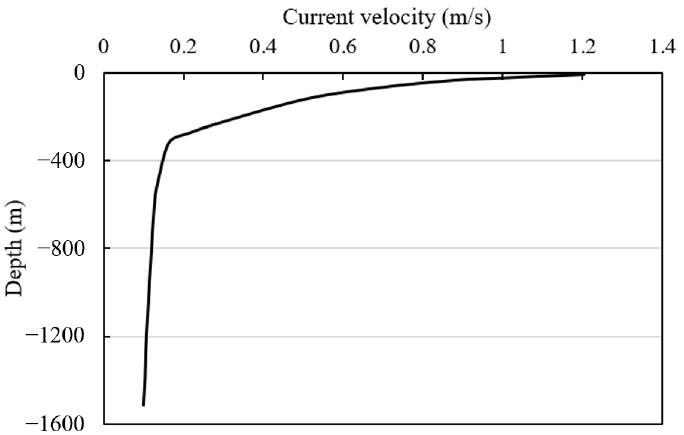
Figure 19. Velocity distribution defined in numerical simulation.